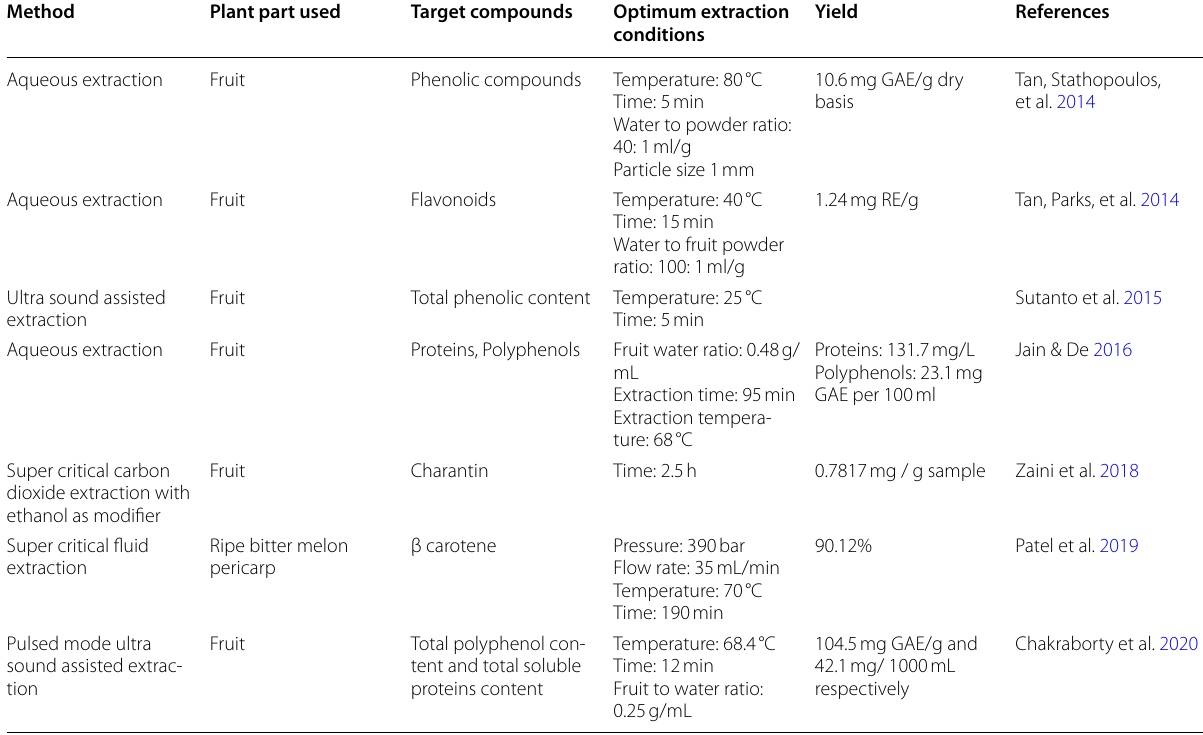
GAE Gallic acid equivalent, RE Rutin equivalent